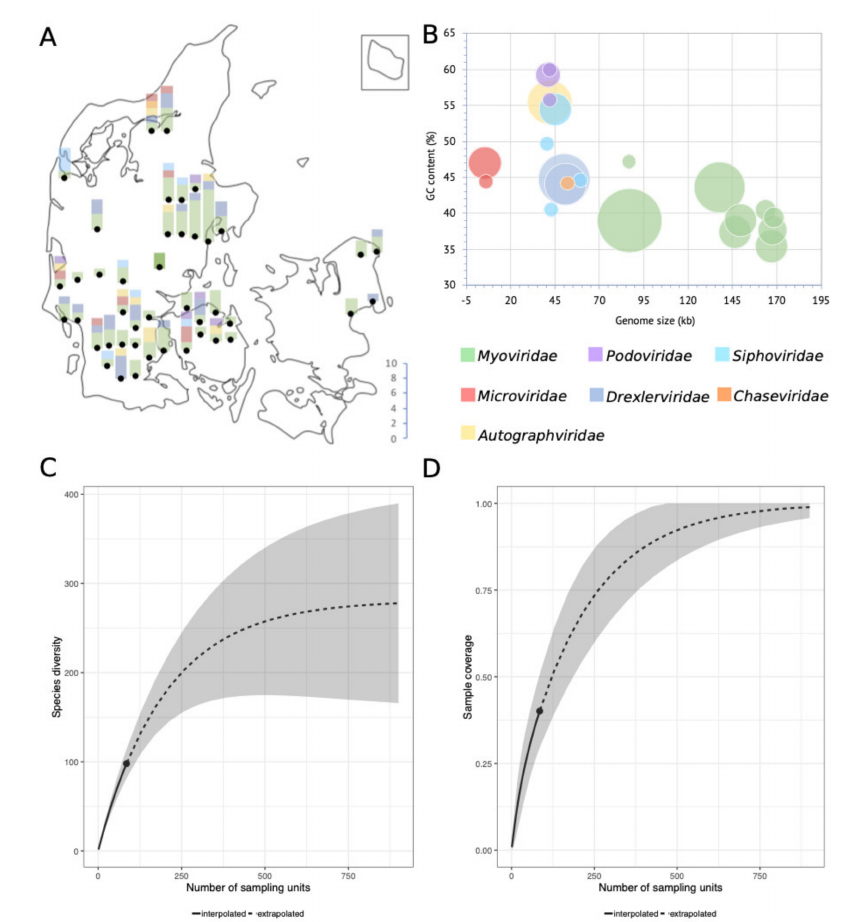
Figure 2. ( A ) Number of phages and taxonomic family distribution per WWTP, as well as approximate geographical location thereof. ( B ) Bubble-diagram of the 104 unique coliphage species displaying genome size and GC content distribution; the area of the bubbles indicates the number of phages. ( C ) Sample completeness curve with confidence intervals (0.95). ( D ) Sample-size-based rarefaction and extrapolation curve with confidence intervals (0.95). Sampling units in figures C and D denote isolated phages ( n =